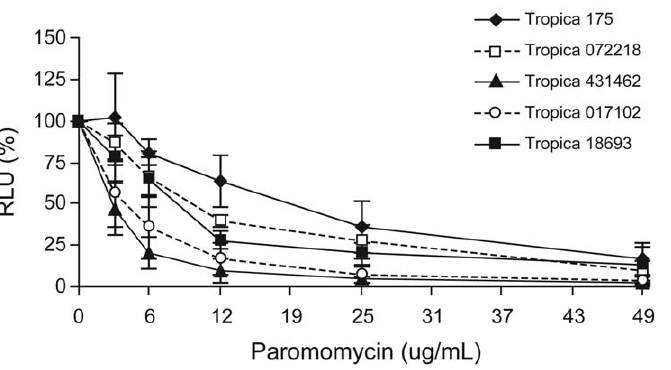
Figure 3. Paromomycin susceptibility of Leishmaniatropica field isolates recovered from soldiers suffering from CL. The four L. tropica isolates from Afghanistan are sensitive to paromomycin as intracellular amastigotes. Intracellular parasites were incubated for 4 days with the indicated concentrations of paromomycin. The mean of two independent experiments done in duplicate is shown. Values are represented as numbers of relative light units